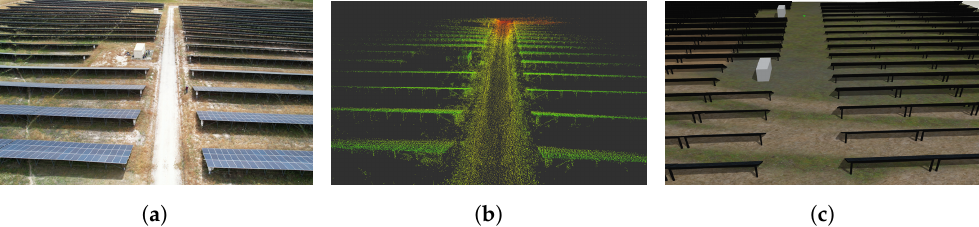
Figure 3. Experimental setup: Solar farm, corresponding 3D map of solar farm obtained from LOAM [18] and digital twin. ( a ) Aerial view. ( b ) 3D point cloud. ( c ) Digital